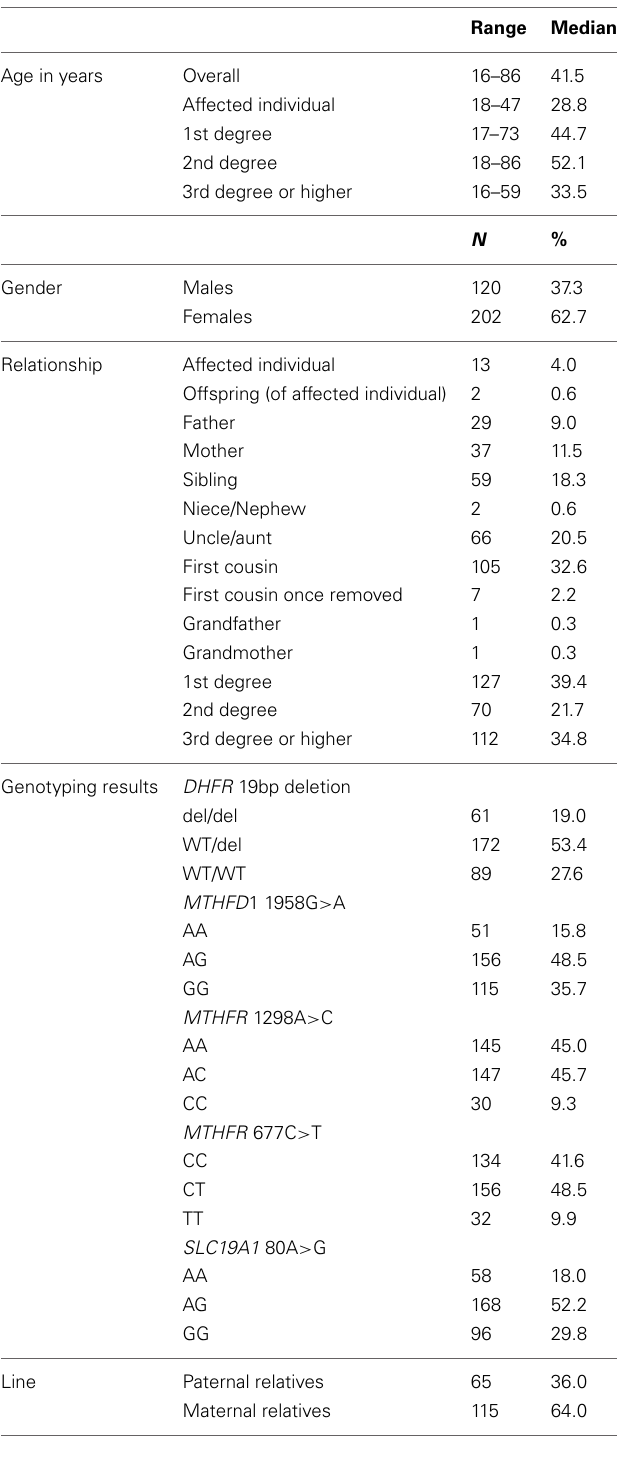
Table 2 | Characteristics of the participants, northeast region of the and relatives (first-degree relatives vs. all other relatives) were Republic of Ireland and Northern Ireland, 1995–2009. dichotomized, the odds ratio for the association of the AA Range Median